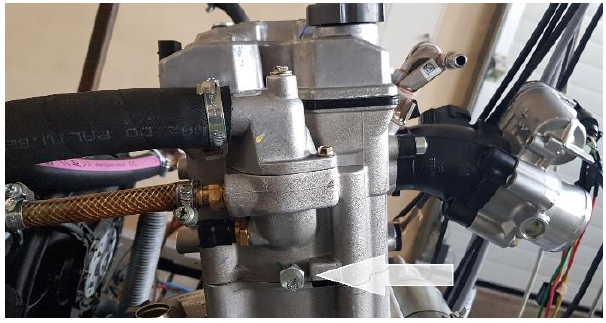
Fig. 5. Engine with closed valve channel